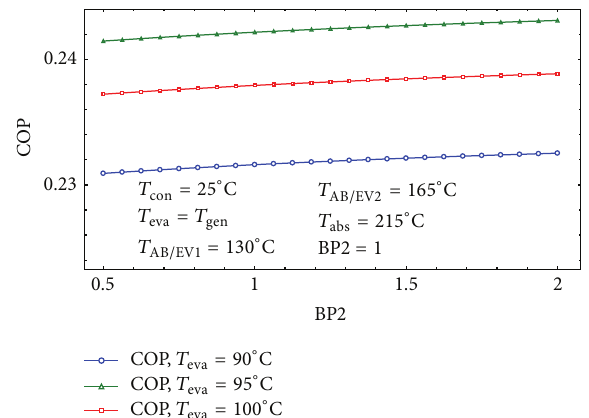
on the COP of the system [27]. eva